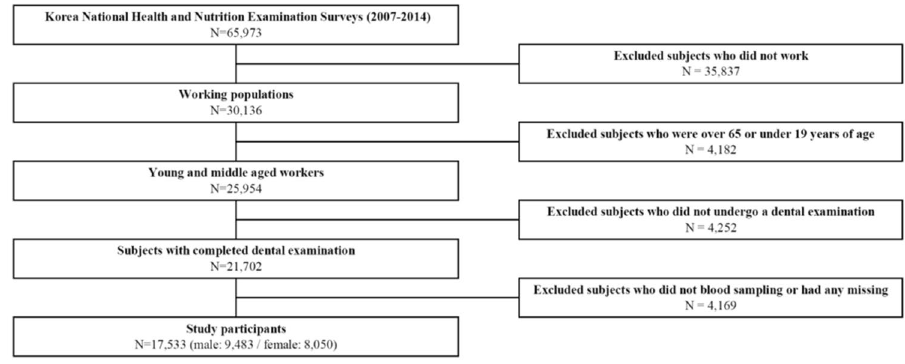
Figure 1. Schematic diagram depicting selection of study